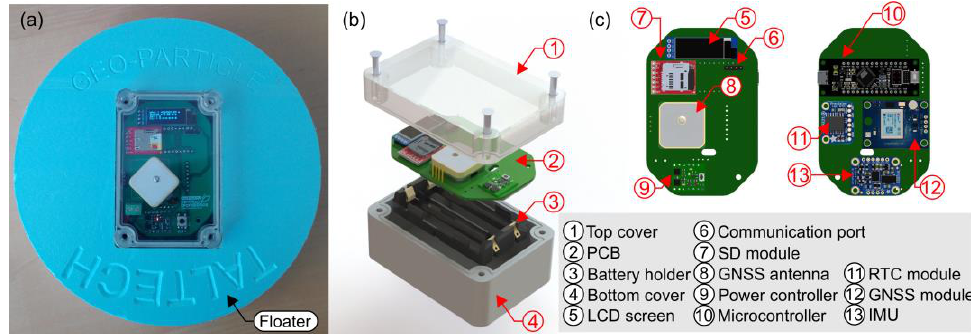
Figure 1. The open drifter and its basic components. ( a ) Drifter installed in an example float. ( b ) Basic hardware components. ( c ) Data logging module with all the components.